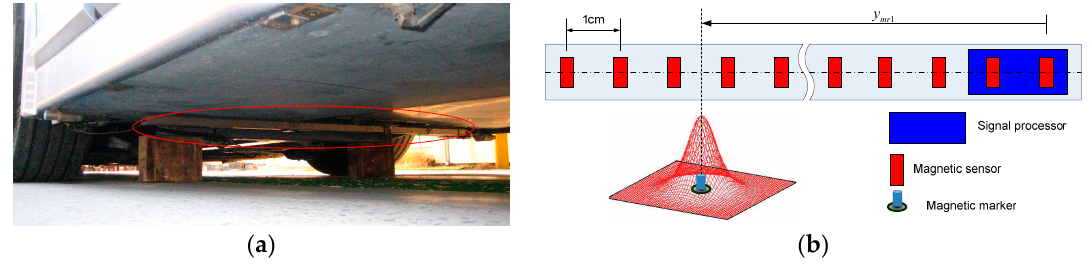
Figure 4. Magnetic ruler. ( a ) Installation; ( b ) Configuration.